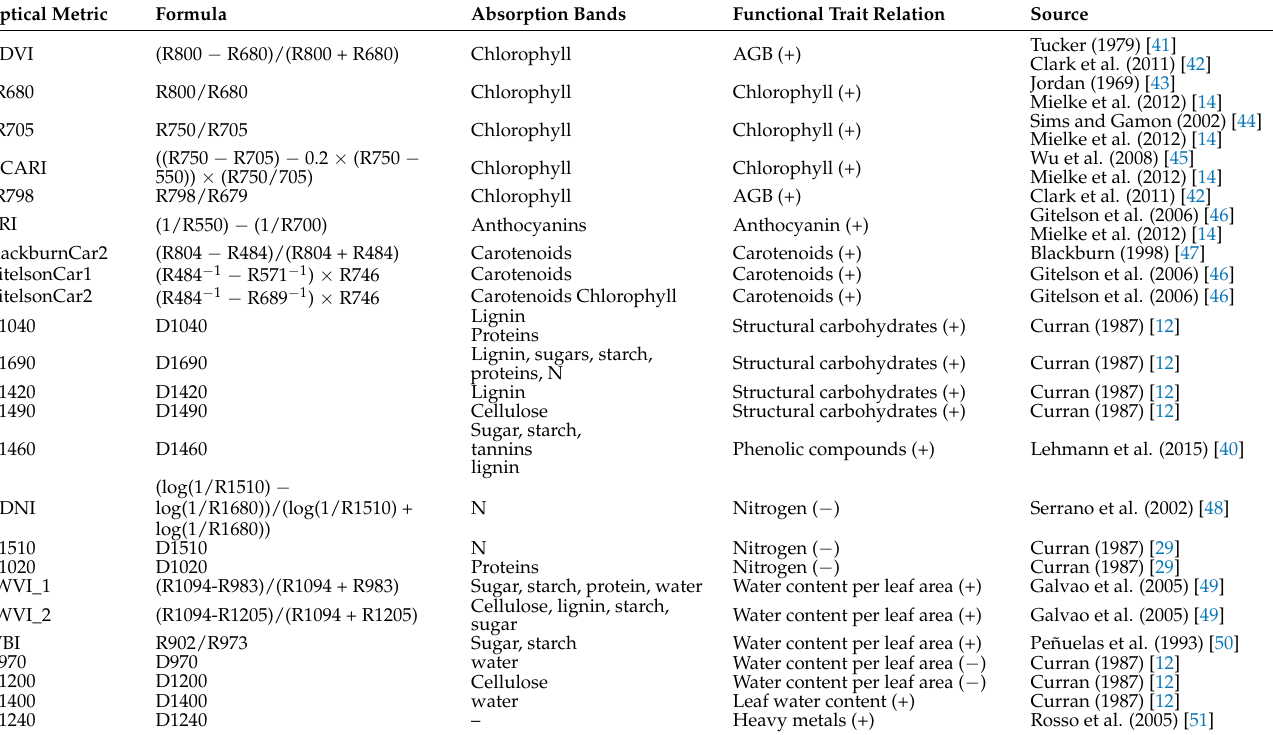
Table 1. Selected commonly used leaf optical metrics for the study. R: reflectance at wavelength (nm); D: first derivate of reflectance at wavelength (nm); AGB: aboveground biomass. (+) and ( − ) indicate the mathematical direction of the relationship between leaf optical metrics and functional traits. Selected references describing the expected relationship between optical metrics and functional traits are provided in the last column. Absorption bands affecting the metrics were taken from Jacquemoud and Ustin [11], except for tannin absorption, which was taken from Lehmann et al.